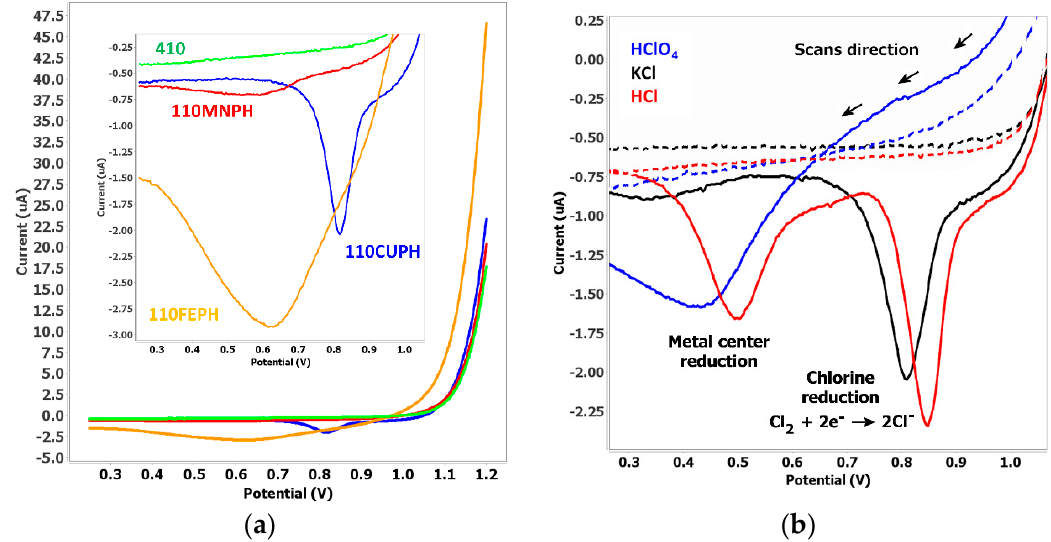
Figure 2. ( a ) Electrochemical behavior of screen ‐ printed electrodes (SPEs) modified with different metal phthalocyanines in 50 mM KCl solution. ( b ) linear sweep voltammetry (LSV) of 100 mM chlorinated species assayed with DRP ‐ 110CUPH. Dotted lines correspond to the DRP ‐ 110 electrodes